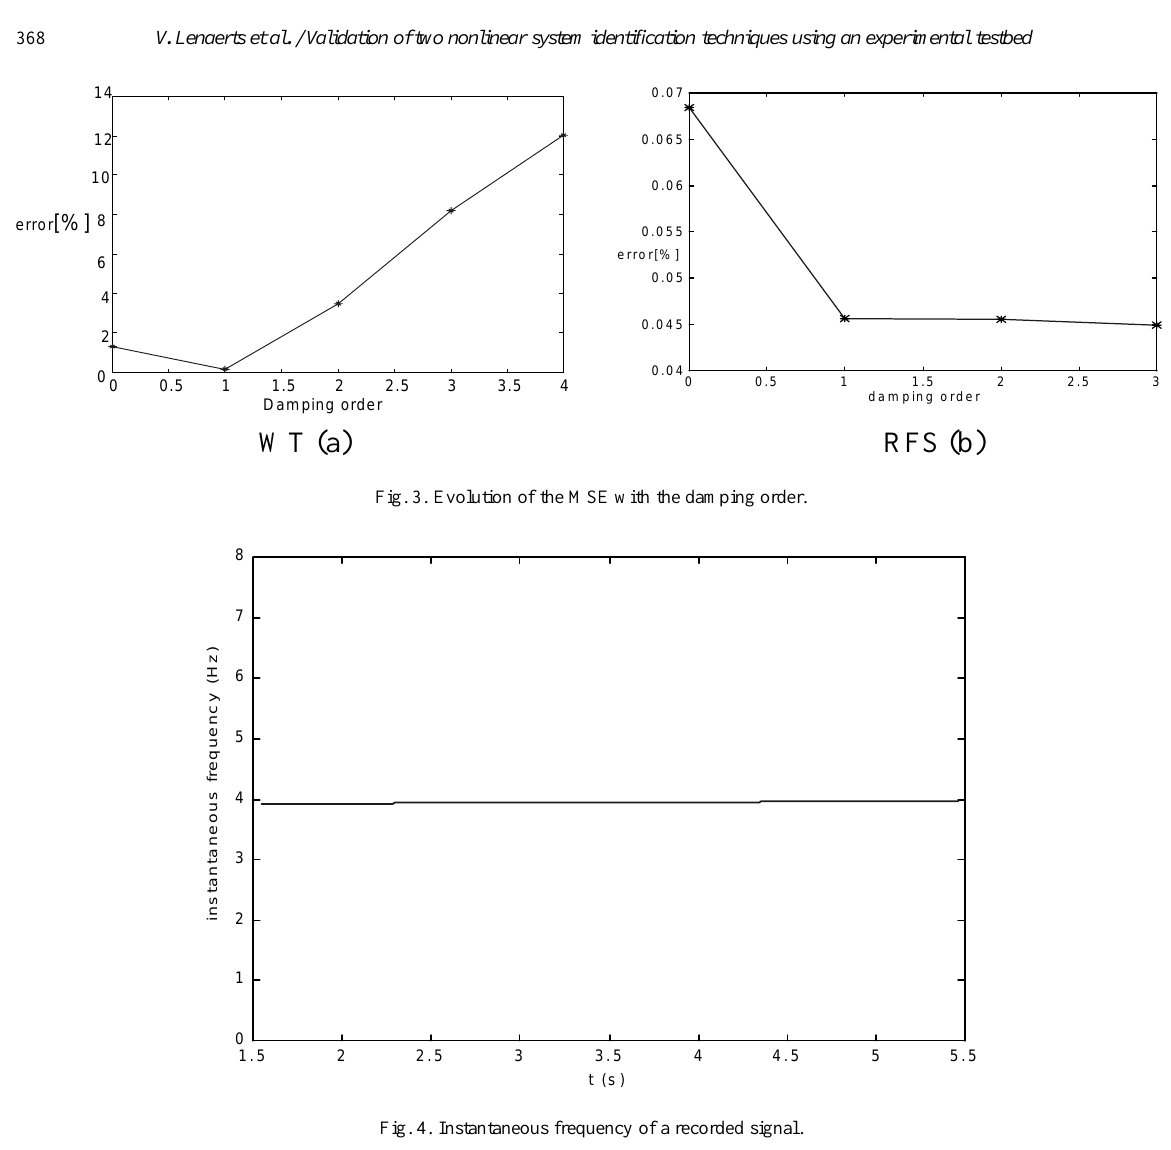
Fig. 4. Instantaneous frequency of a recorded